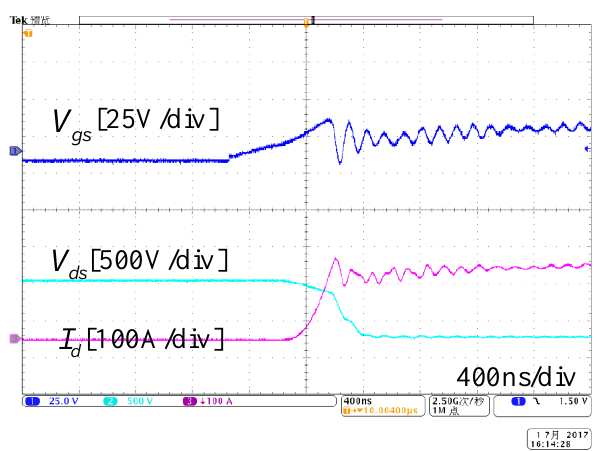
Figure 9. Waveforms of DP test.